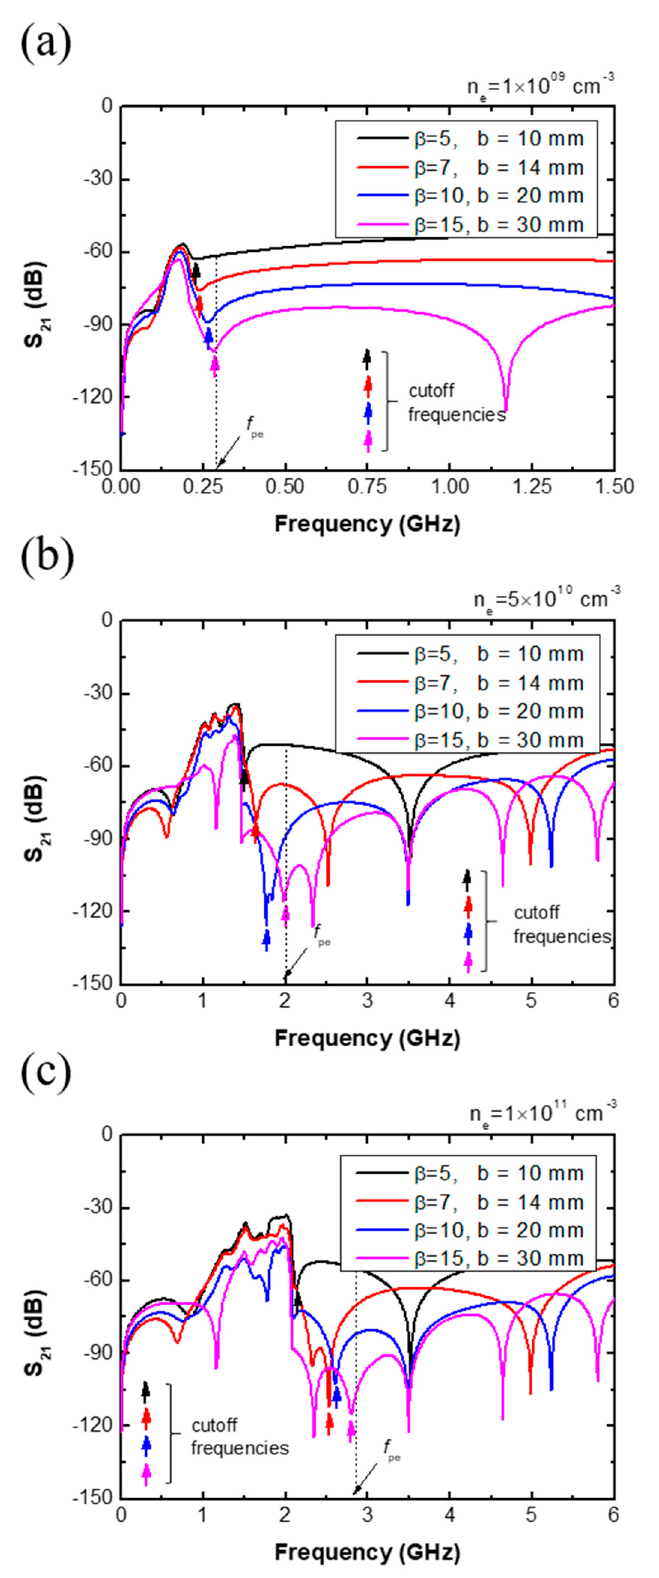
Figure 4. S 21 spectra of the RCP from various normalized antenna distances ( β ) with electron densities of ( a ) n e = 1 × 10 9 cm − 3 , ( b ) 5 × 10 10 cm − 3 , and ( c ) 1 × 10 11 cm − 3